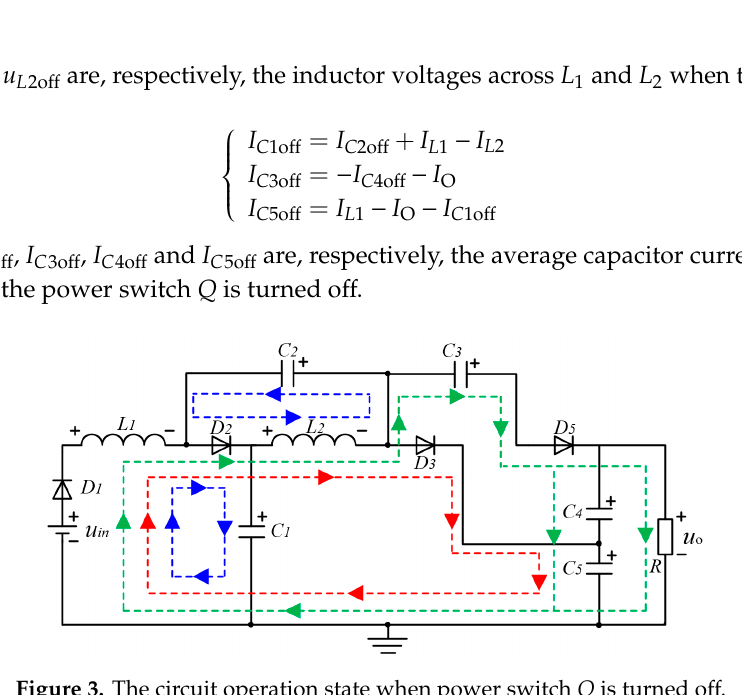
Figure 3. The circuit operation state when power switch Q is turned o ff